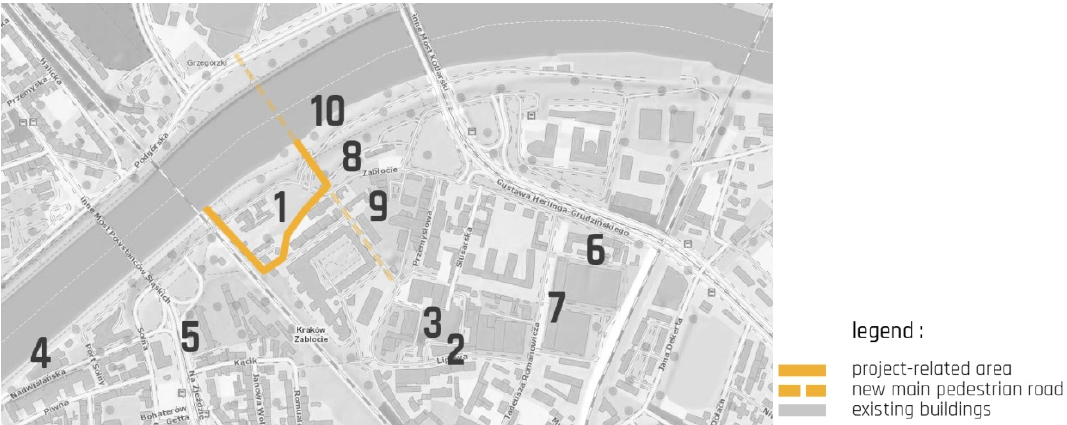
Figure 11. Cultural dominants of Podolski Boulevard (Bulwar Podolski): (1) Project-related area; (2)